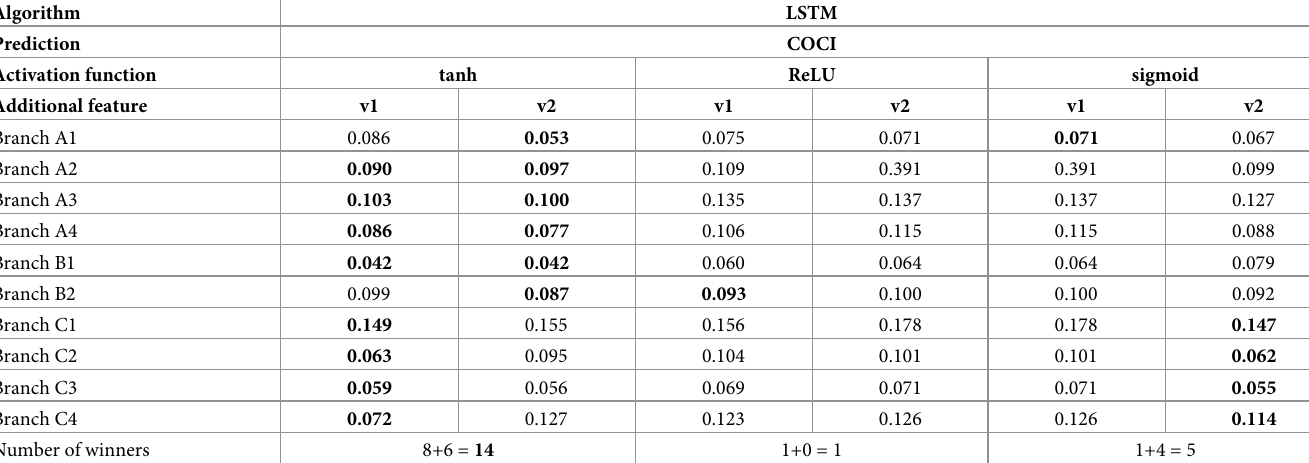
Table 8. RMSE results of COCI predictions by using LSTM with different activation